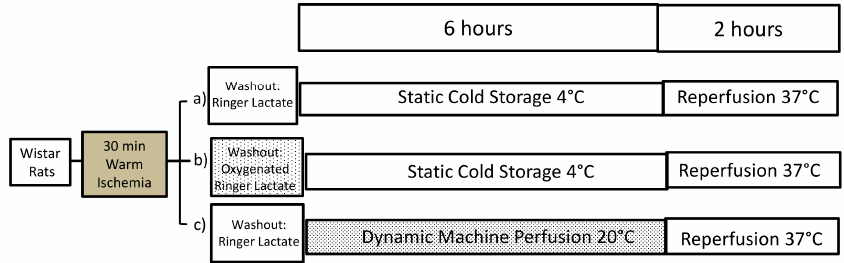
Figure 1. The experimental protocol we adopted using livers from DCD Wistar rats. In the control group ( a ) the DCD graft was preserved with University of Wisconsin (UW) solution at 4 °C (Cold Storage, CS). In group ( b ) an oxygenated washout was performed before CS preservation. In group ( c ) the livers were preserved by machine perfusion preservation at 20 °C ( n = 7/group).